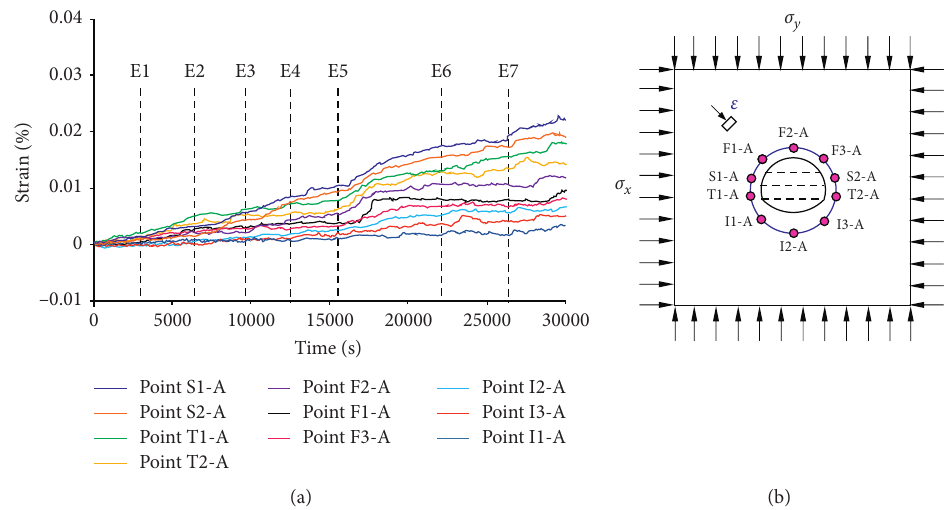
Figure 12: Evolution of surrounding rocks strains around the tunnel: (a) the curves of radial strain versus time and (b) taking the monitoring circle A around the tunnel as an example.